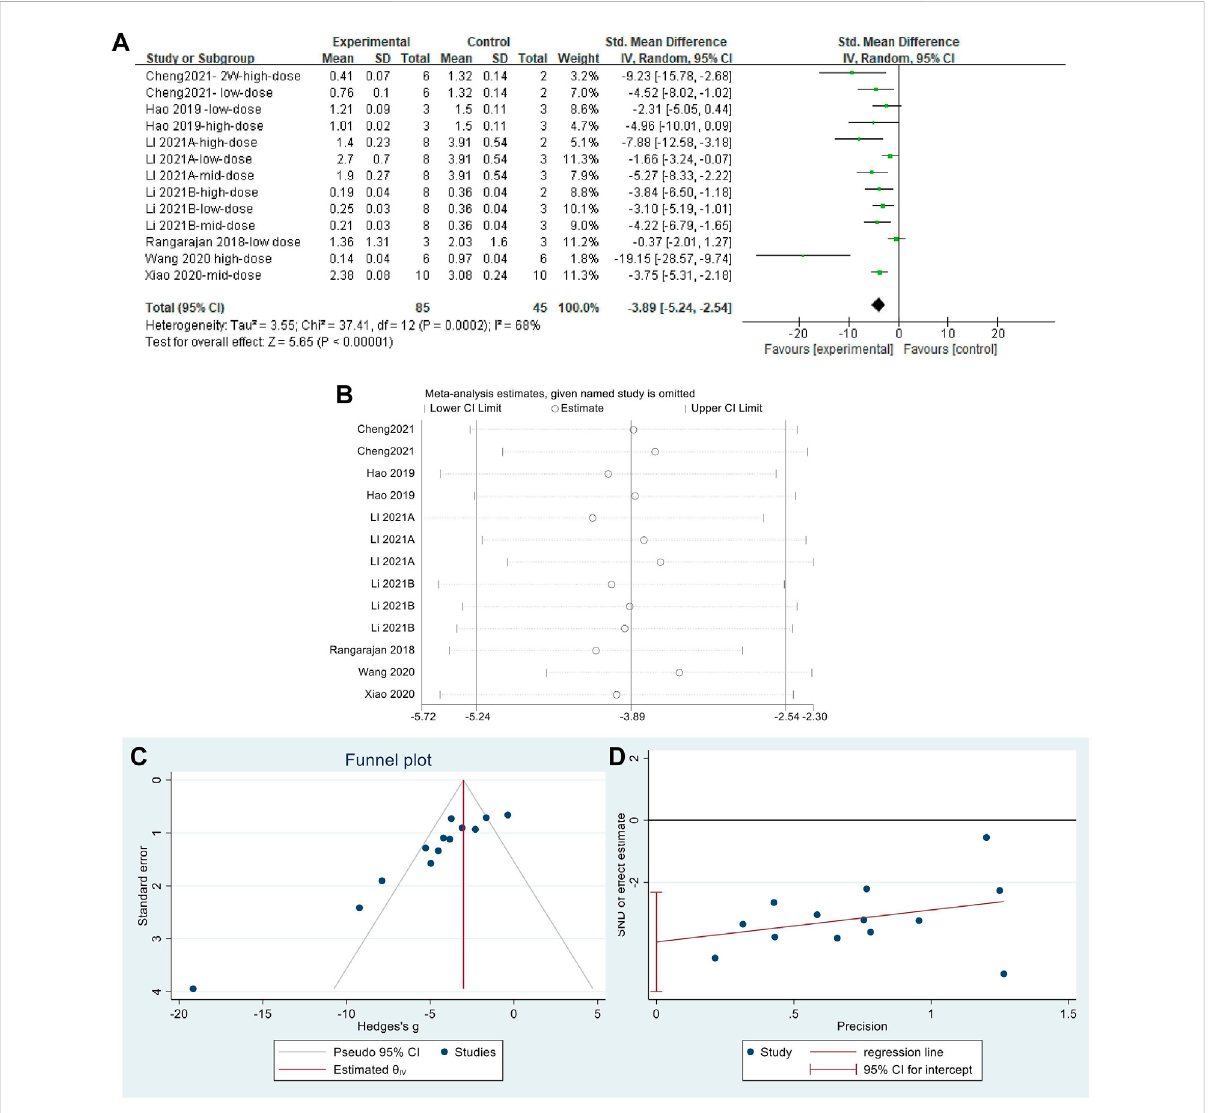
FIGURE 9 EffectofMETon α -SMAcontentinlungtissuesofthePFanimalmodels; (A) Forestplotofthe α -SMA; (B) Sensitivityanalysisof α -SMA; (C) Funnel plot of α -SMA; (D) Egger ’ s test for α